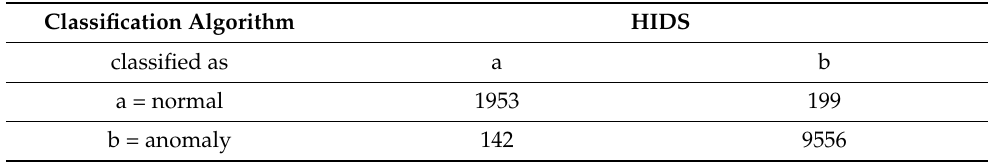
Table 11. Confusion matrix using HIDS.